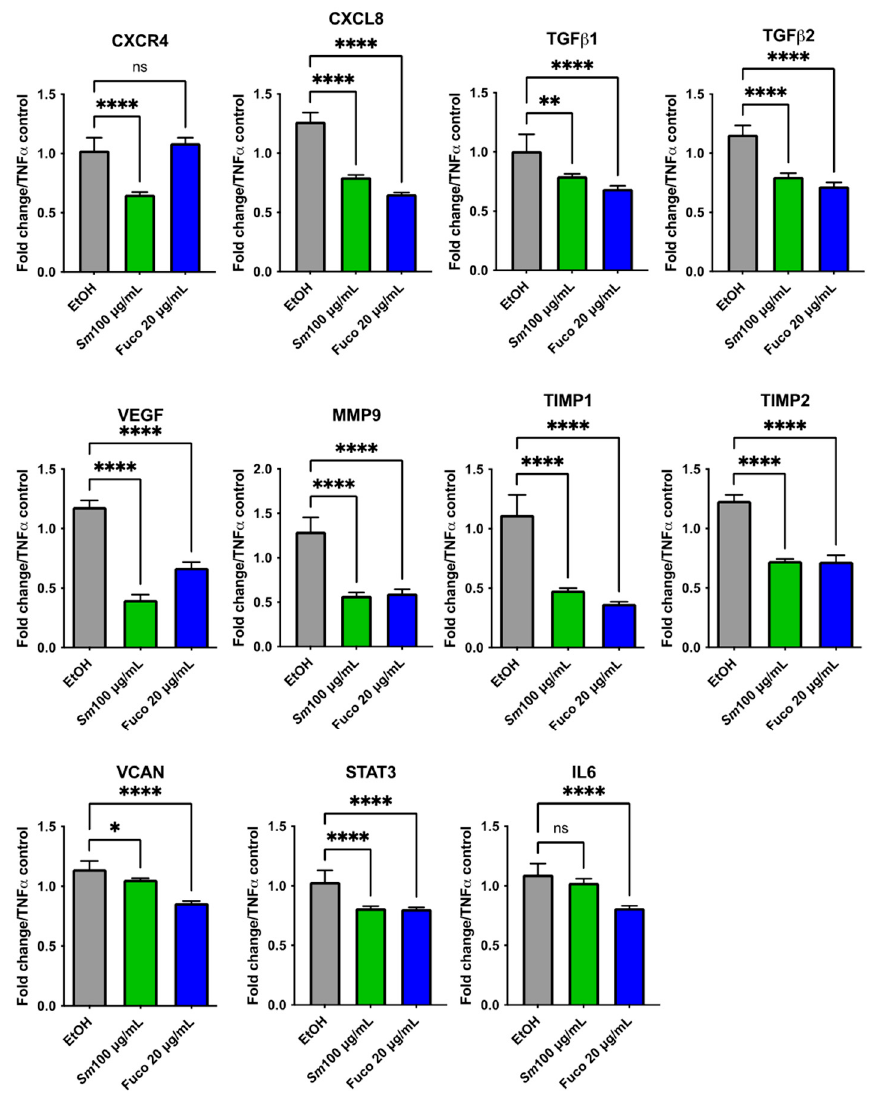
Figure 10. Gene expression pro fi ling in endothelial cells treated with S. marinoi and marine pigment fucoxanthin. The ability of Sm (100 µg/mL) ( A ) and Fuco (20 µg/mL) ( B ) to inhibit cytokine expression in HUVECs stimulated with TNF α (10 ng/mL) was determined by qPCR following 6 h of treatment. Data are shown as relative mRNA expression normalized to β -actin and TNF α - stimulated control, EtOH (vehicle control), mean ± SEM, one-way ANOVA, * p < 0.05, ** p < 0.01, **** p < 0.0001, ( n =